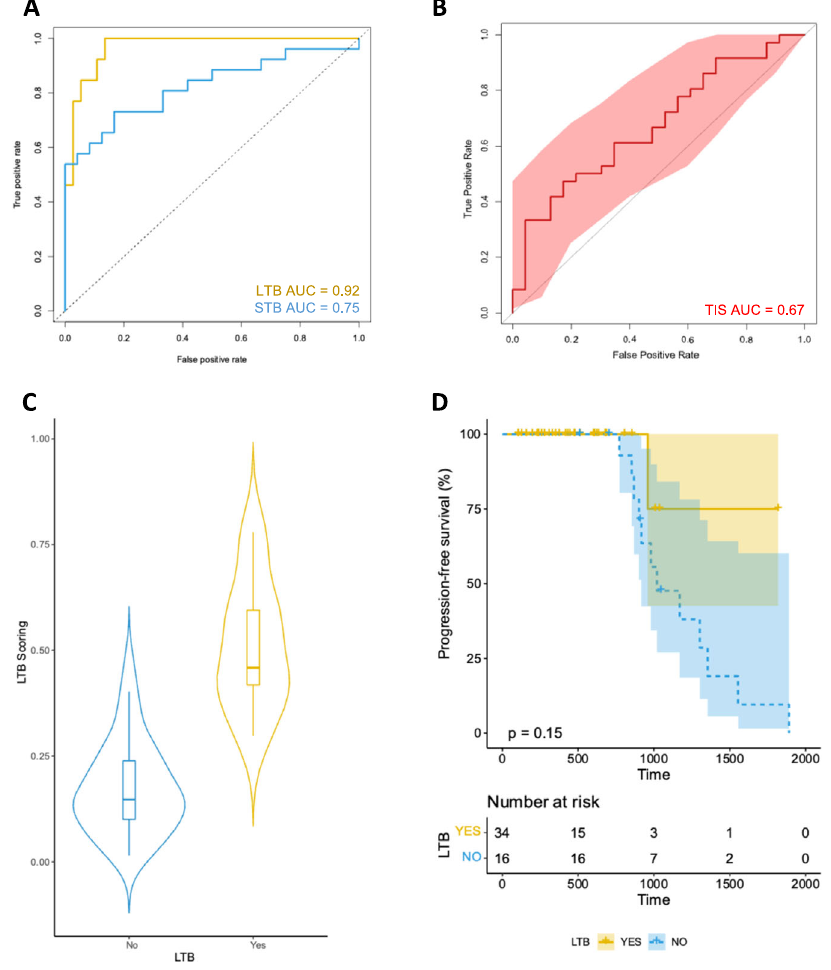
Fig. 4 Development of the 12-gene signature that predicts LTB from programmed cell death protein 1-based immunotherapies in patients with advanced or metastatic melanoma. A Receiver operating characteristic curves for LTB and STB signatures in the discovery set. B Receiver operating characteristic curves for the TIS signature in the discovery set. C Violin plot showing the distribution of scores according to LTB outcome in the discovery set. D Kaplan – Meier curve for PFS for patients ranked high according to the 12-gene LTB signature score in the discovery set. For the training set the low subgroup has a minimum score of 0.0007, 1st quantile of 0.045, median of 0.11, mean of 0.18, 3rd quartile of 0.28 and maximum score of 0.54; the high subgroup has a minimum score of 0.25, 1st quartile of 0.41, median of 0.53, mean of 0.53, 3rd quartile of 0.63 and maximum value of 0.89. The error bars correspond to the 95% con fi dence intervals. LTB long-term bene fi t, STB short-term bene fi t, AUC area under the curve, PFS progression-free